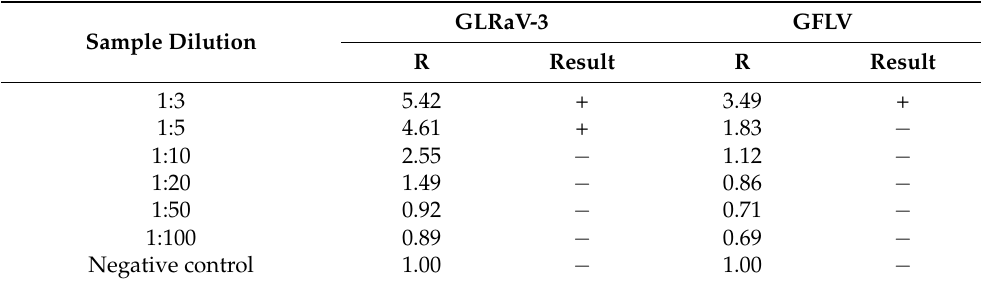
Table 1. ELISA results (+ = positive/detectable, − = negative/undetectable) on serial dilu- tions from 1:3 to 1:100 of virus sources for GLRaV-3 and GFLV. The R value was defined as R = OD sample /OD negative control